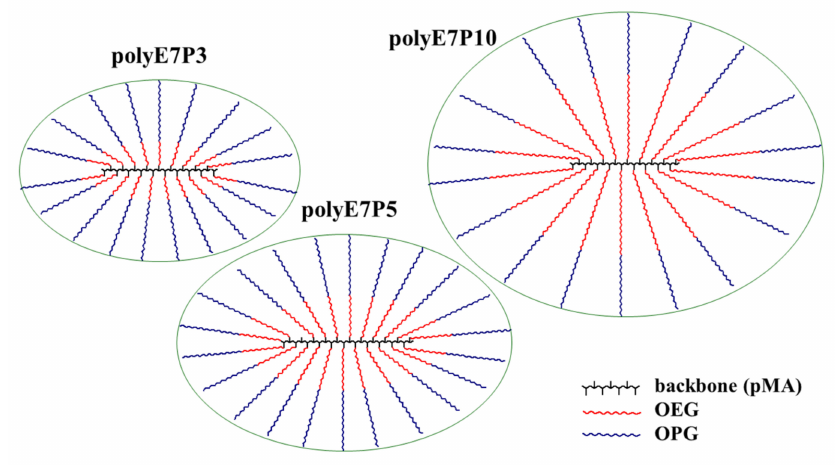
Figure 4. Simplified schemes of the molecules of